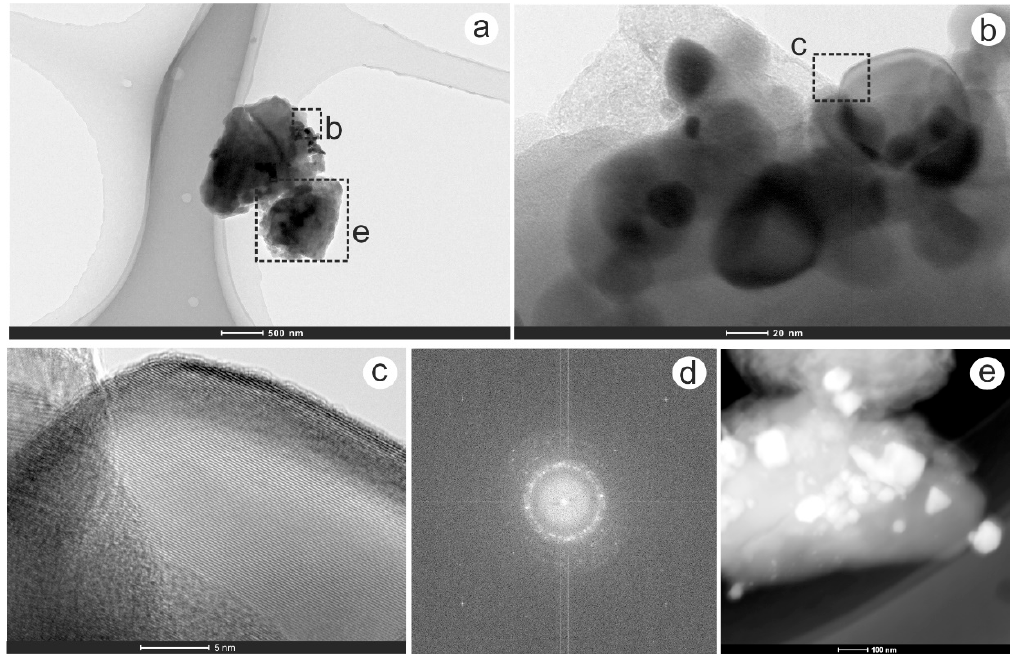
Figure 4. A Cu–Zr–Au–C–O particle in soils over gold deposit; ( a ) TEM image; ( b ) TEM image; ( c ) HRTEM image; ( d ) SAED pattern; ( e ) STEM-HAADF image. Some small nanoparticles adsorb on the surface of a big particle.